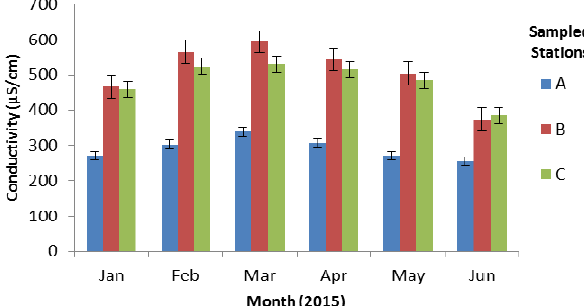
Fig. 3. The monthly mean variation of water conductivity (µS/cm) of the water sampled from Saba River